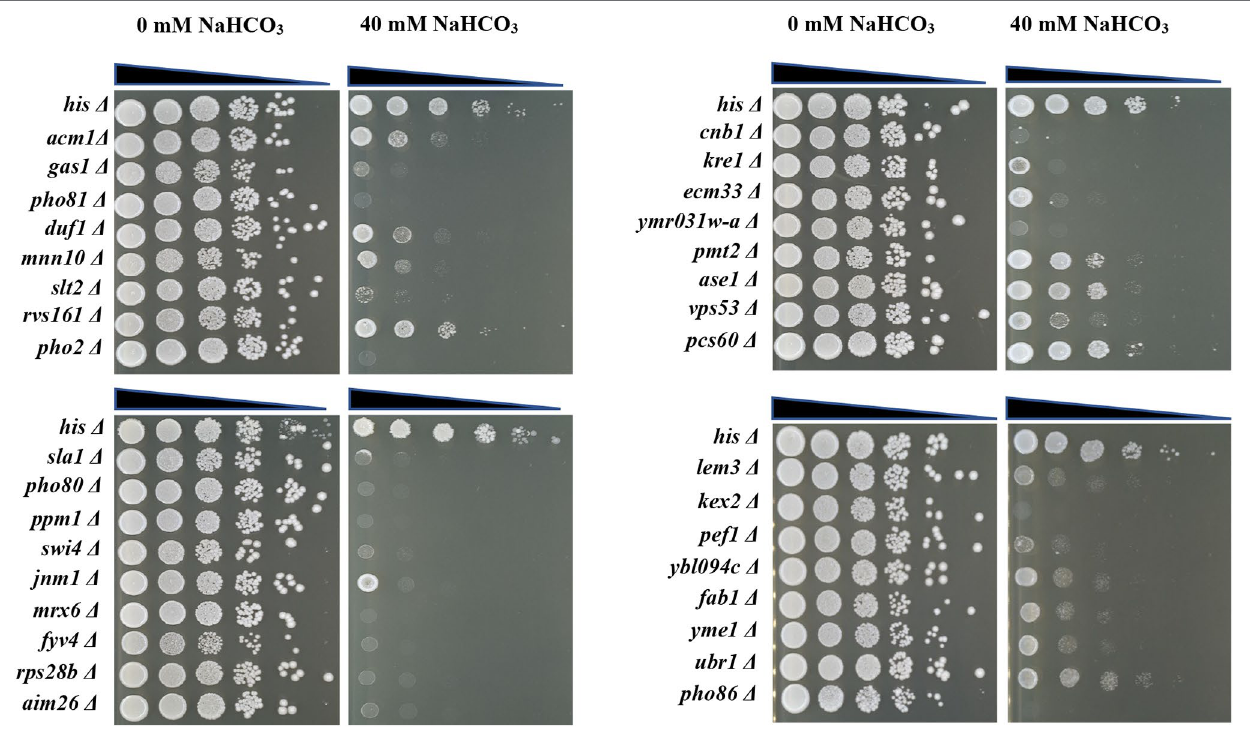
FIGURE 2 | Spot test of the 33 selected deletion mutants. The control strain and deletion mutants were grown to mid-log phase in YPD + G418 liquid medium and then diluted to an OD 600 = 0.5. Each strain was serially diluted in a 10-fold gradient and 5 μ l were spotted onto YPD + G418 agar plates either containing 0 mM NaHCO 3 or 40 mM NaHCO 3 and incubated at 30 ° C. Plates were photographed after 48